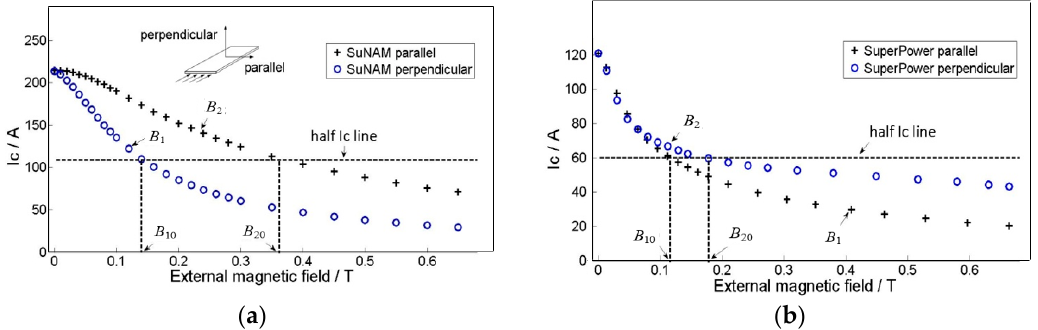
Figure 4. Measured field dependency for SuNAM tape and SuperPower tape. ( a ) B 1 represents the lower curve and B 10 is the field when the current is half of the critical current on the B 1 curve; ( b ) B 2 represents the upper curve and B 20 is the field when the current is half of the critical current on the B 2 curve. Table 2. Field dependency parameter for SuNAM and SuperPower